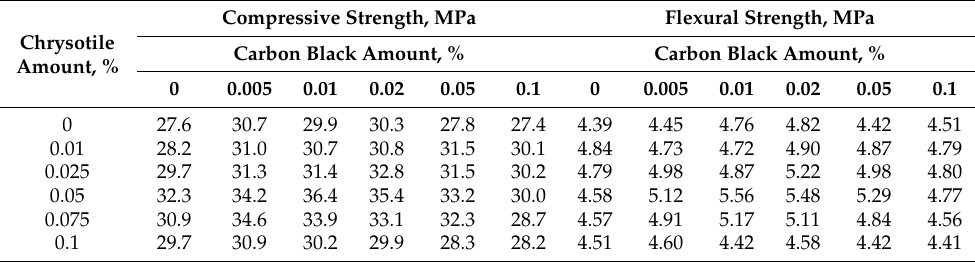
Table 1. Compressive and flexural strength of samples at various ratios of components in com- plex